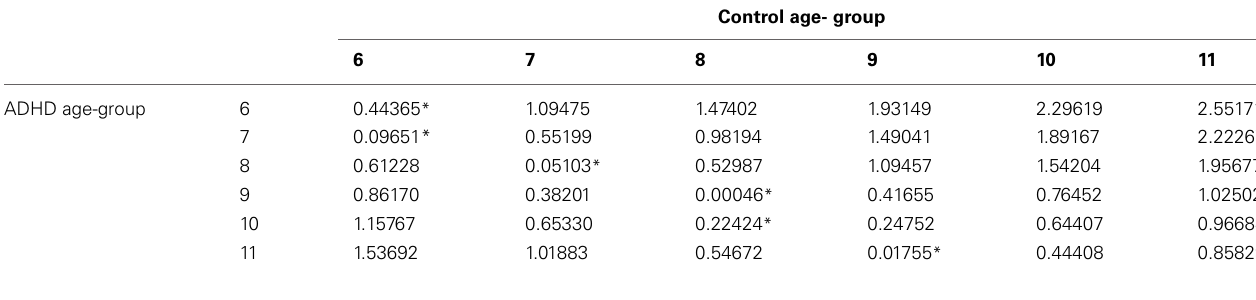
Table B3 | ADHD and control groups with the minimal difference in the hyperactivity parameter, using Cohen’s D measure.